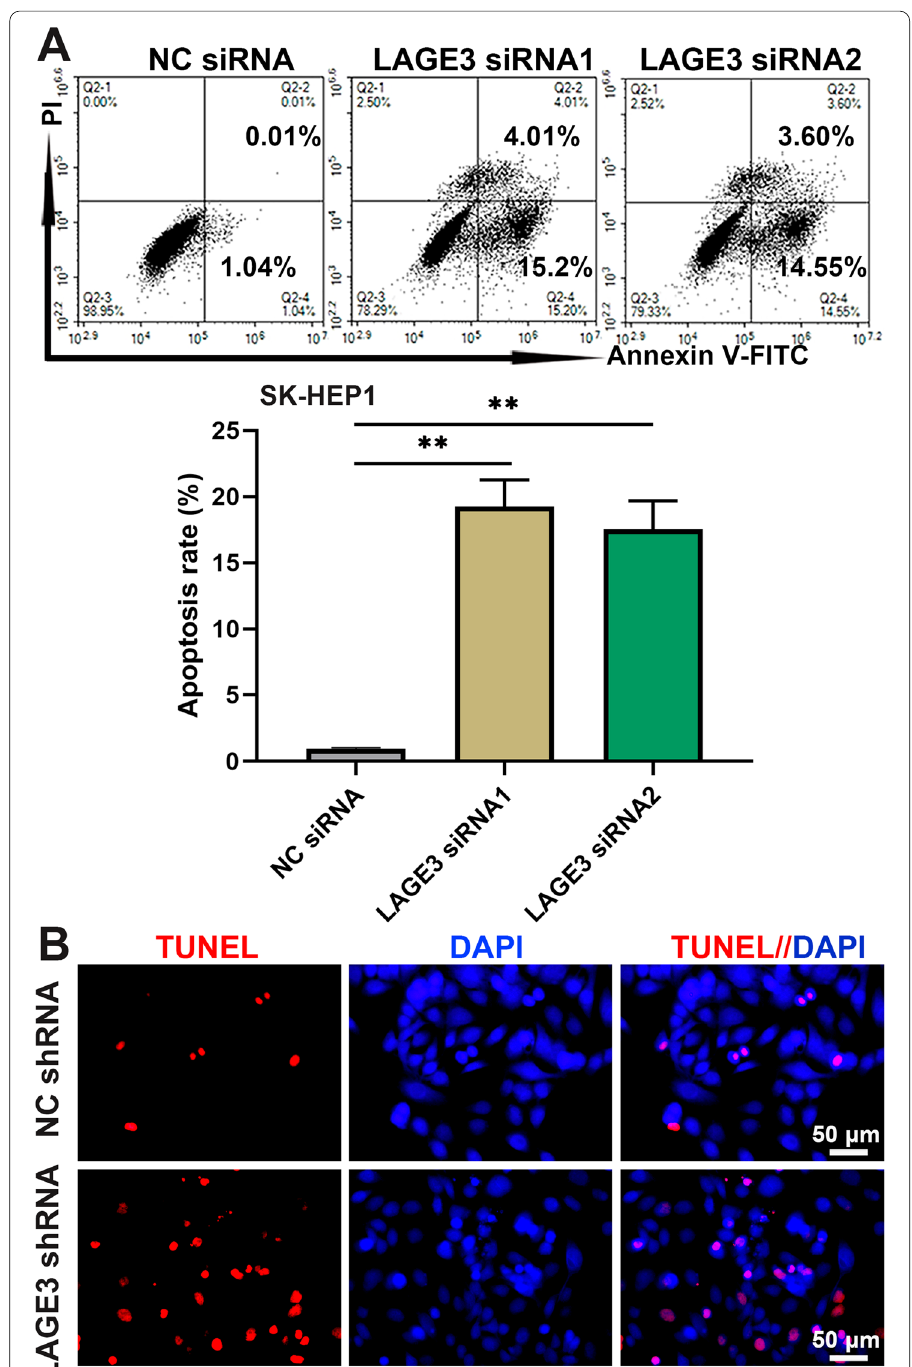
Fig. 3 LAGE3 repressed the apoptosis of HCC cells. SK-HEP1 cells were transfected with LAGE3 siRNA1/2 or LAGE3 shRNA. A Annexin V-FITC/PI labeled cells were analyzed by flow cytometry to determine the early apoptosis rate. B TUNEL staining of late apoptotic cells. Data are shown as mean **p <